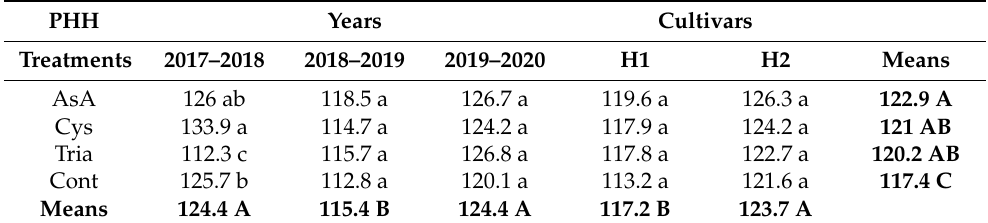
Table 5. Effects of seed priming and foliar treatment with bioactive substances on canola plant height at harvest (PHH). PHH Years Cultivars